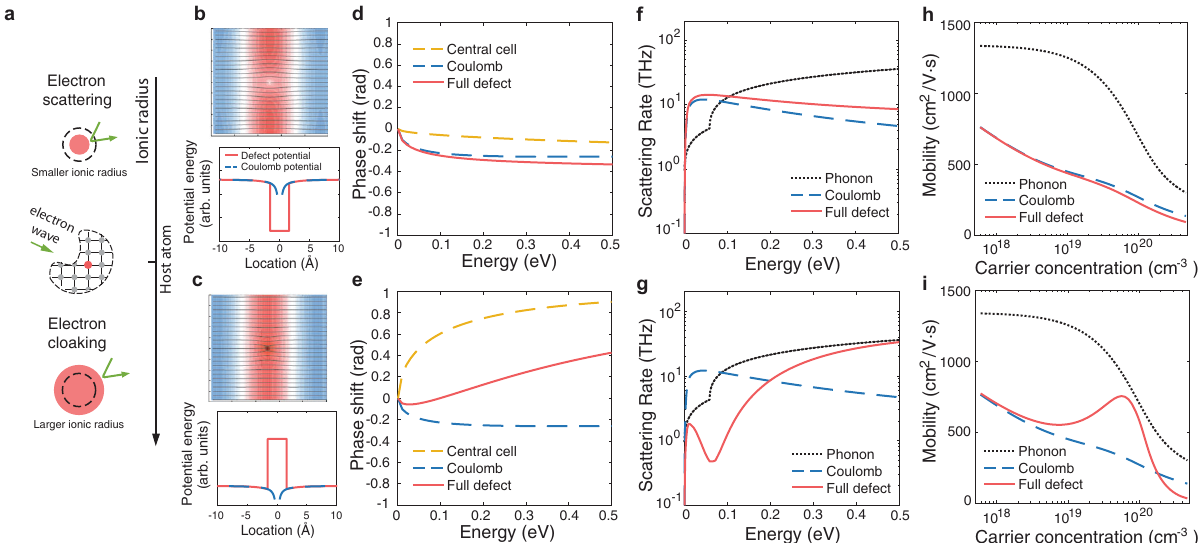
Fig. 1 Impact of charged defects on electron transport. a Illustration of a propagating electron wave scattered by the perturbed electronic potential of an n-type dopant. The defect potential contains two parts, a long-range part due to the attractive Coulomb fi eld, and a short-range part that depends on the bonding environment of the defect (the central cell potential). The ionic radius can be used as a good indicator for the sign of the central cell potential. Depending on the ionic radius of the dopant atom, one of two general scenarios can play out. If the dopant atom has a smaller ionic radius than the host atom, the perturbation tends to create an additional attractive force for electrons (electron-scattering scenario); if the dopant atom has a larger ionic radius, it tends to create a repulsive force which then opposes the long-range Coulomb potential (electron-cloaking scenario). b , c Defect potentials and scattered electron wavefunctions corresponding to two different scenarios ( b : electron scattering, c : electron cloaking). The central cell potential is represented by a simpli fi ed rectangular pro fi le. The streamlines show the probability fl ux and the colors indicate the real part of the wavefunctions. In the case of electron cloaking ( c ), unperturbed streamlines are recovered away from the defect (located at the center). The domain size is 158.8 Å × 158.8 Å and the electron energy is 0.1 eV. d , e Phase shifts of scattered wavefunctions with angular momentum quantum number of l = 1 for two scenarios ( d : electron scattering, e : electron cloaking). f , g Modeled intrinsic electron scattering rates due to electron – phonon interactions, in comparison to those considering electron-defect scatterings ( f : electron scattering, g : electron cloaking). The calculation assumes a parabolic band to illustrate the general impact of defect scatterings and uses partial wave analysis to calculate the scattering rates due to defects (see details in Methods). h , i Electron mobility with respect to the carrier concentration ( h : electron scattering, i : electron cloaking). While mobility at high carrier concentrations is traditionally believed to be limited by Coulomb scattering, a strong opposing central cell potential can be harnessed to break this limit, leading to high mobility limited only by the intrinsic electron – phonon interactions, as shown in ( i